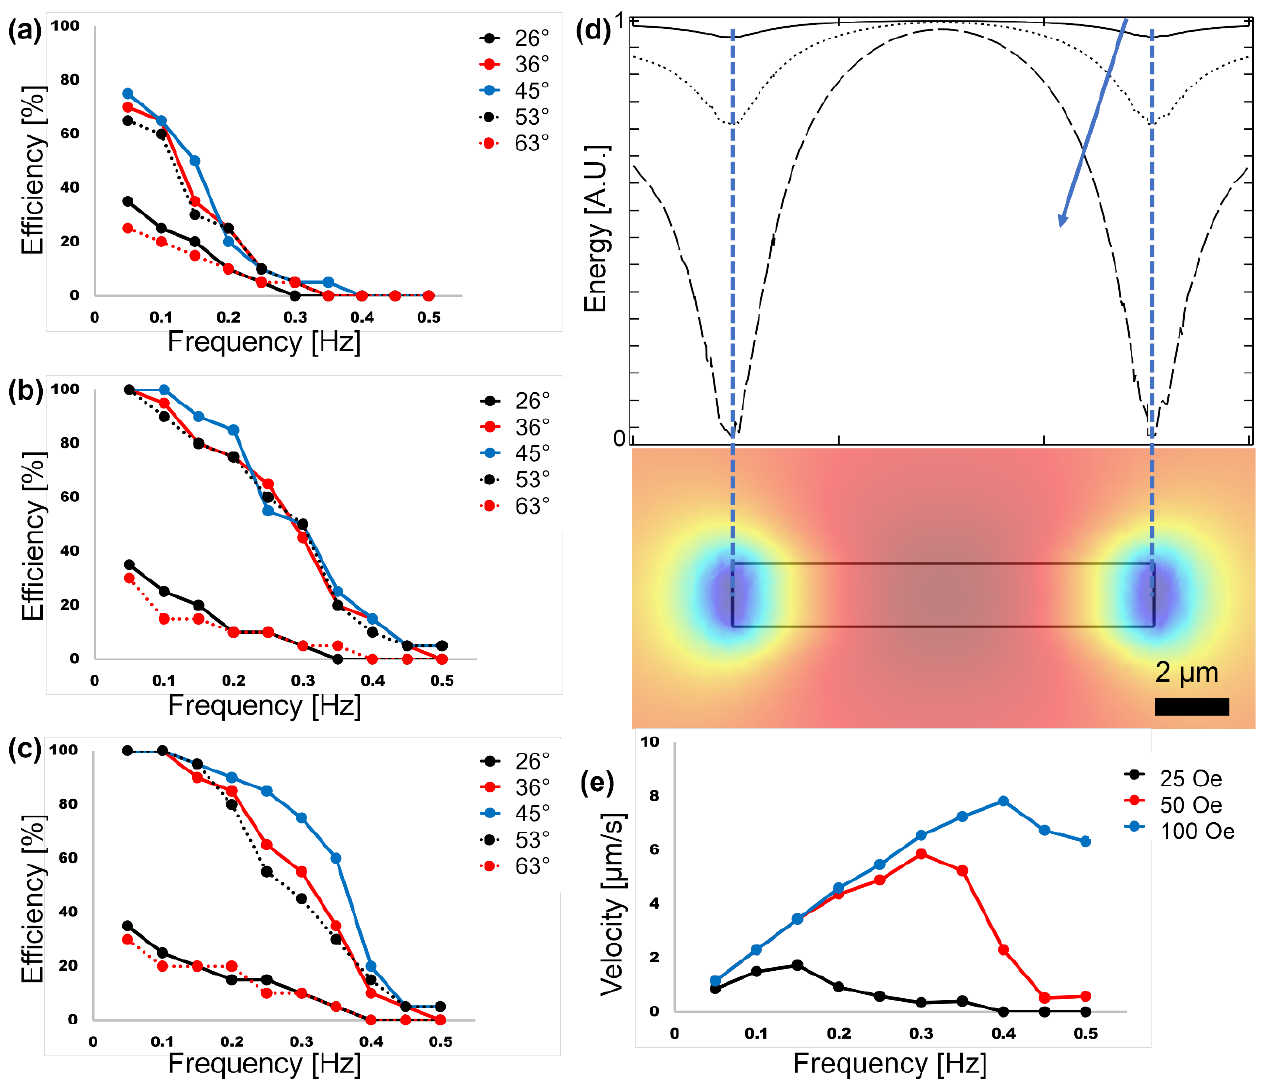
Figure 6. The particle transport efficiencies (i.e., the number of periods at which the particles move flawlessly) as a function of frequency for various cone angles are plotted. The experiments are repeated for magnetic field strengths of ( a ) 25 Oe, ( b ) 50 Oe, and ( c ) 100 Oe. In these experiments, the particle mean diameter is 8.4 µ m. The field cones are α = 26 ◦ (solid black), α = 37 ◦ (solid red), α = 45 ◦ (solid blue), α = 53 ◦ (dotted black), and α = 63 ◦ (dotted red). ( d ) The energy along the I bar main axis when exposed to the magnetic field along that axis for magnetic field strengths of 25 Oe (solid line), 50 Oe (dotted line), and 100 Oe (dashed line) are plotted. The blue arrow indicates increasing magnetic field strength. ( e ) The particle velocities versus frequency at magnetic fields with various strengths are plotted.